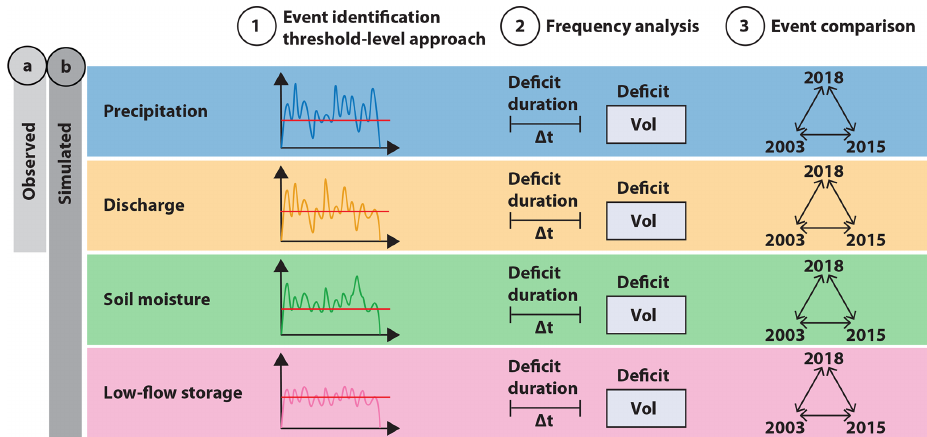
Figure 2. Drought severity assessment framework employed in this study. The severity of the 2003, 2015, and 2018 drought events was assessed in terms of precipitation and discharge using (a) observed and (b) simulated data and in terms of soil moisture and low-flow storage using only simulated data. The assessment consisted of three steps: (1) event identification using a threshold-level approach, (2) drought frequency analysis, and (3) comparison of the three events in 2003, 2015, and